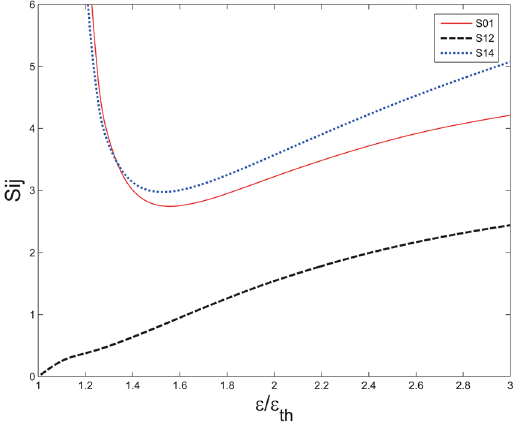
Figure 5. The minimum variance as a function of pump power. The external coupling coefficient is fixed at = γ γ c